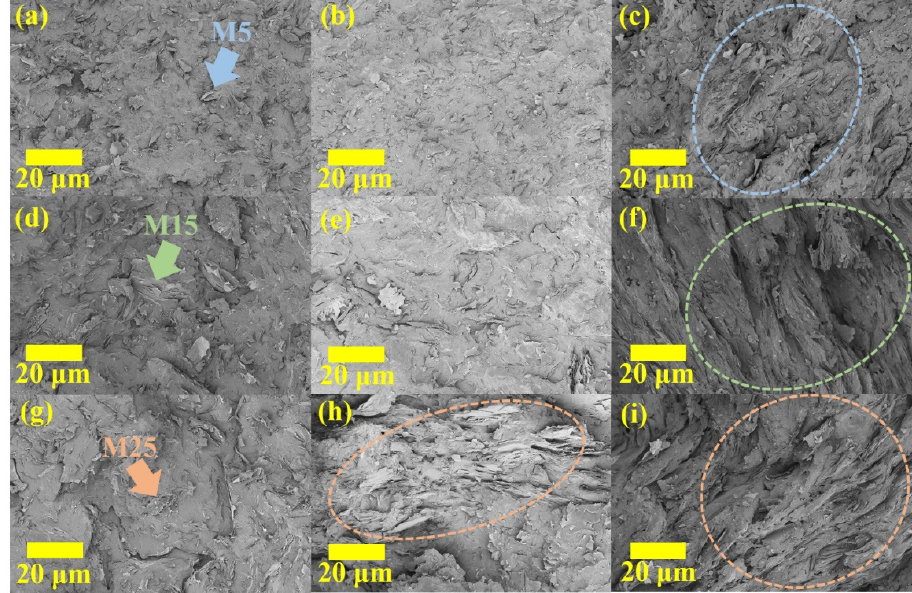
Figure 3. FE-SEM images of the composites with M5 ( a ) 10 wt.%, ( b ) 20 wt.%, and ( c ) 30 wt.%; M15 ( d ) 10 wt.%, ( e ) 20 wt.%, and ( f ) 30 wt.%; and M25 ( g ) 10 wt.%, ( h ) 20 wt.%, and ( i ) 30 wt.%.